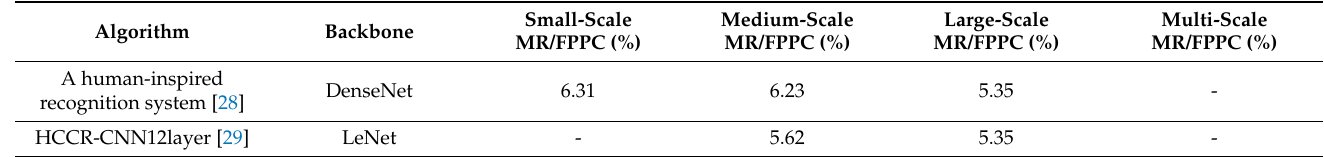
Table 5. The FC-MSCCD model beat other SOTA models on our benchmark dataset in terms of multi-scale detection and even with different scales in the